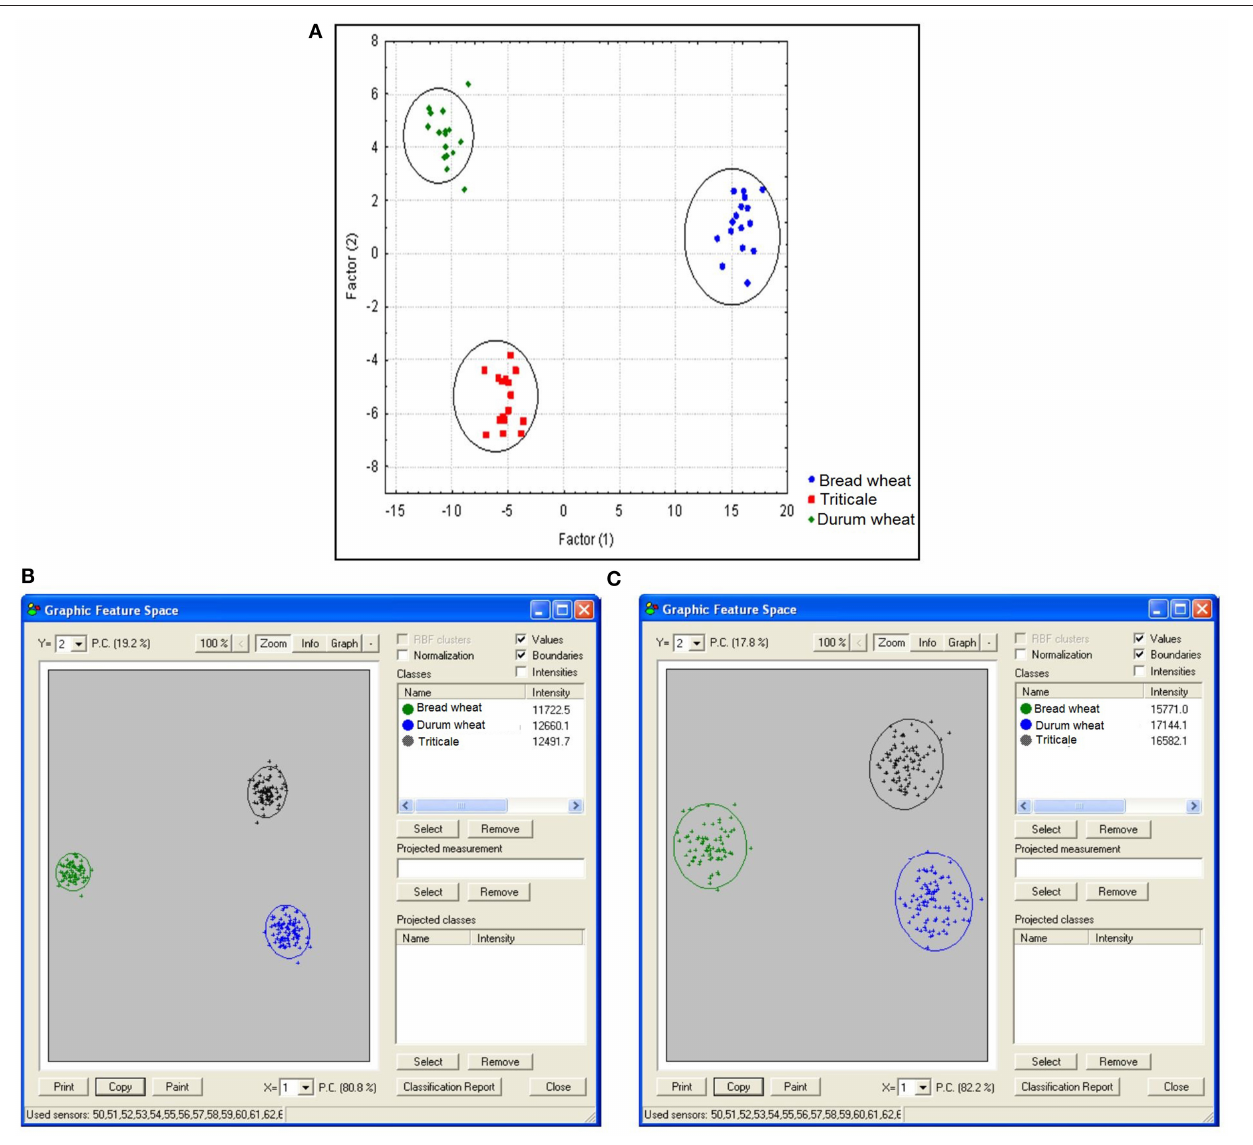
FIGURE 4 | Results of discriminatory analysis covering contents of volatile compounds identified in samples of bread wheat, durum wheat and triticale. Wilks’ lambda = 0.0003778. Function value test F = 0.8586911, calculated for this statistic at a probability level of P = 0.00001 (A) . A map for the range of masses of 50–250 (B) . A map for the range of masses of 50–150 (C)